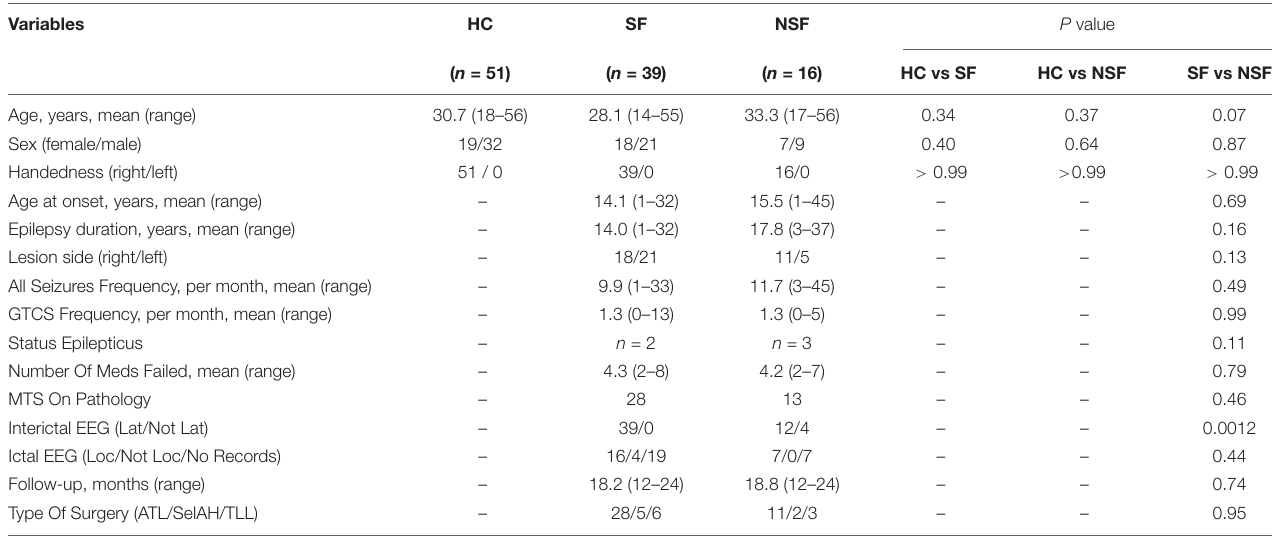
TABLE 1 | Demographic and clinical characteristics from study